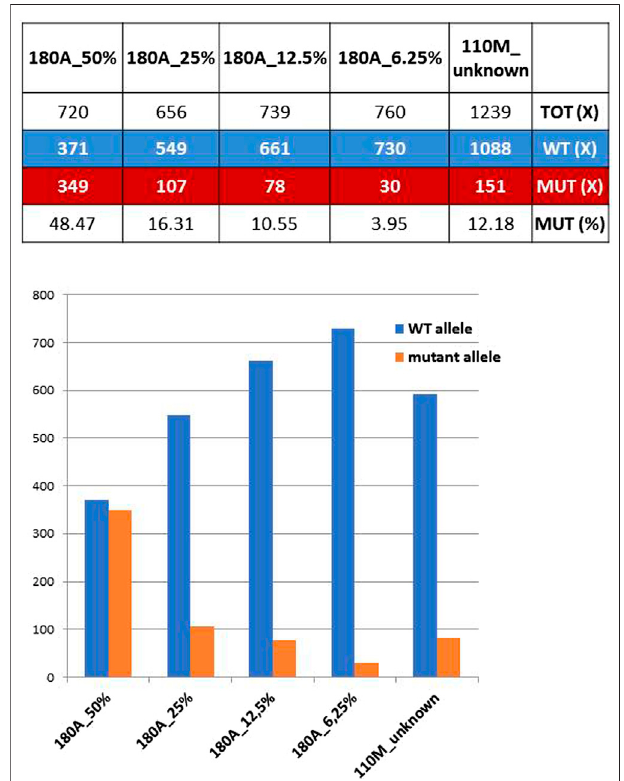
FIGURE 1 | Coverage ratios for mutant and wild-type (WT) alleles obtained from known dilutions of a de fi ned heterozygous control (ID#180A) are compared with those of ID#110M parent. Bottom: WT and mutant allele reads shown above are reported as bars of a